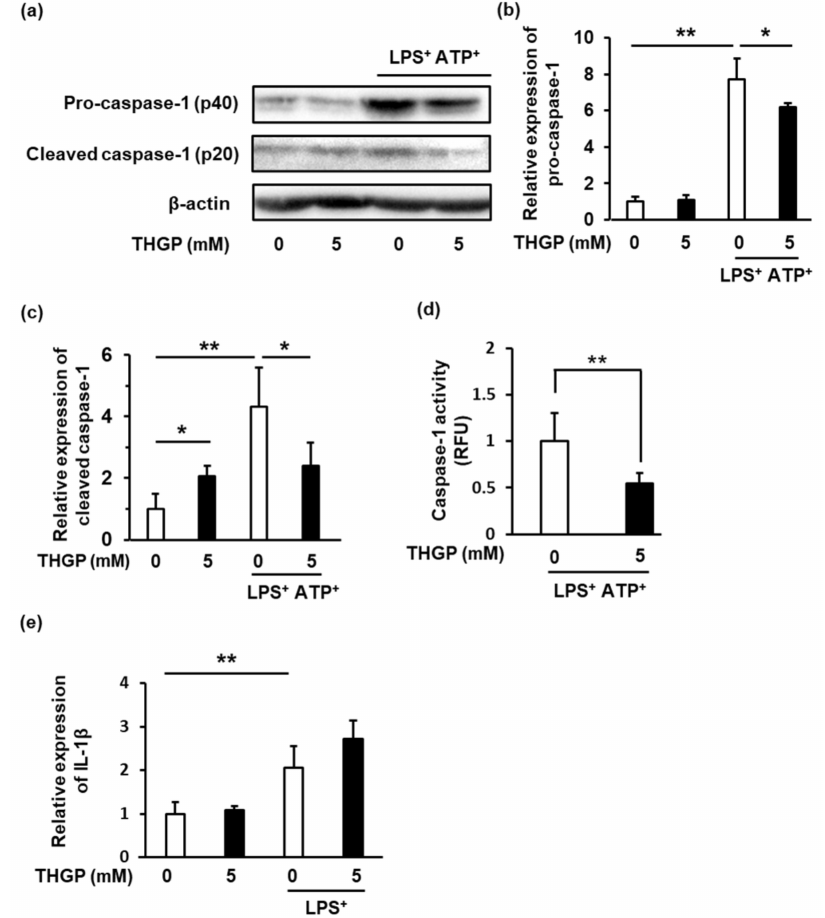
Figure 2. The effect of THGP on caspase-1 expression in THP-1 cells. ( a – c ) The effect of THGP on the expression of Caspase-1 in THP-1 cells treated with or without 10 µ g/mL LPS and 1 mM ATP was investigated by western blotting. β -Actin was used as an internal standard to quantify the expres-sion of each protein. ( d ) Caspase-1 activity in THP-1 cells treated with 10 µ g/mL LPS, 1 mM ATP and/or 5 mM THGP was measured using a Caspase-Glo®1 Inflammasome Assay Kit. ( e ) The effect of